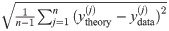
The interaction between CRP and DNA.Anisotropy of 32-bp fluorescein-labeled lac promoter binding to CRPD/S at different concentrations of cAMP. An anisotropy of 1 corresponds to unbound DNA while higher values imply that DNA is bound to CRP. In the presence of cAMP, more CRP subunits will be active, and hence there will be greater anisotropy for any given concentration of CRP. The sample standard deviation 1n-1∑j=1n(ytheory(j)-ydata(j))2 is 0.01, with the corresponding parameters given in Tables 1 and 2. Data reproduced from Ref. [29].